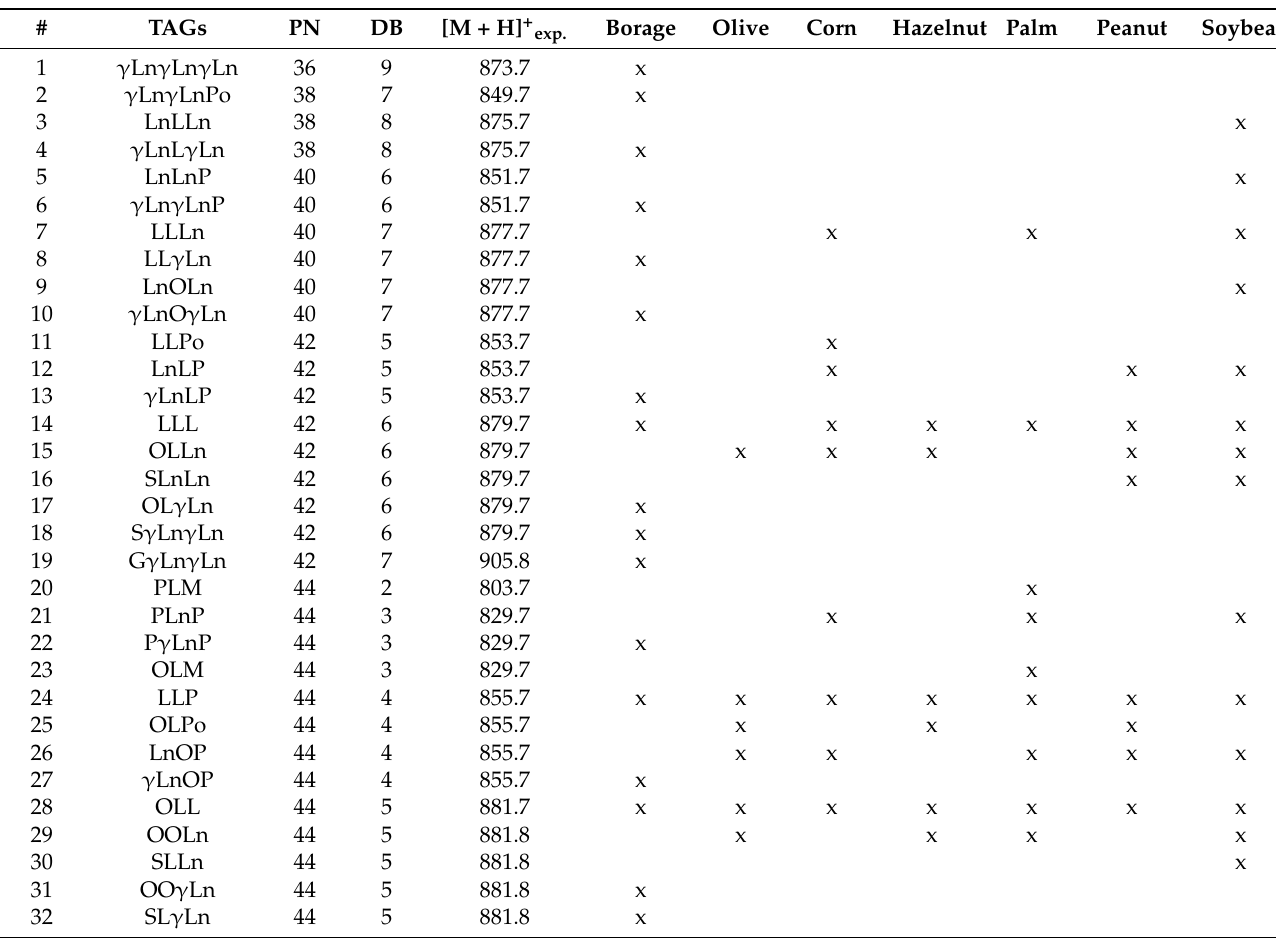
Figure 1. SubFC-APCI-MS TAG profiles obtained for an extra virgin olive oil sample employing a gradient of EtOH ( A ) and IPA ( B ) into CO 2 . Column: Ascentis Express C18, 100 × 30 mm L × i.d., 2.0 μ m d.p. , partially porous. Column temperature, 20 °C; ABPR, 150 bar and 50 °C; gradient elution of EtOH ( A ) or IPA ( B ) into CO 2 , 2% to 20% B in 20 min at 1.0 mL/min. Injection volume, 2.0 μ L. Peak labeling as in Table 1. Table 1. TAG composition 1 of the oil samples investigated, reported according to the increasing PN (partition number) obtained by SubFC on an ODS column. The DB (double bond) number and the experimental m/z values of the protonated molecular ions ([M + H] + exp. ) are also